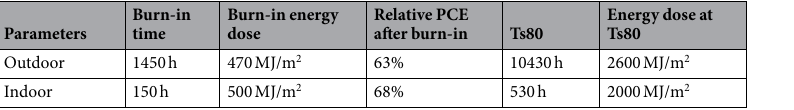
Table 2. A summary of key parameters determined from indoor and outdoor lifetime testing